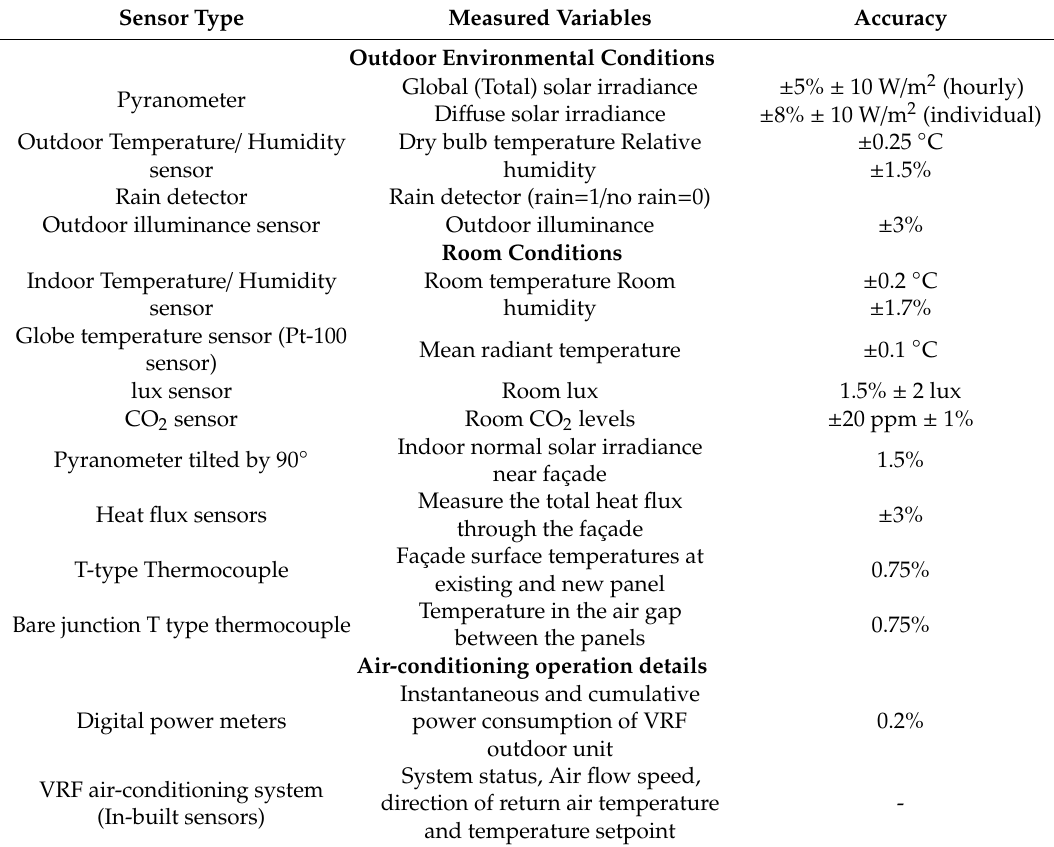
Table 3. Set of measured parameters with accuracy range.